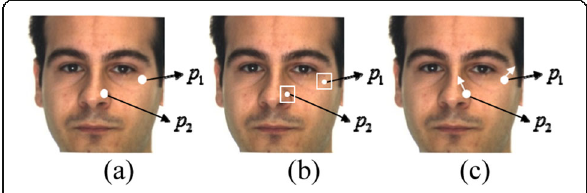
Fig. 3 Characteristics of the landmark including a pixel value, b regional block, and c gradient magnitude of a pixel